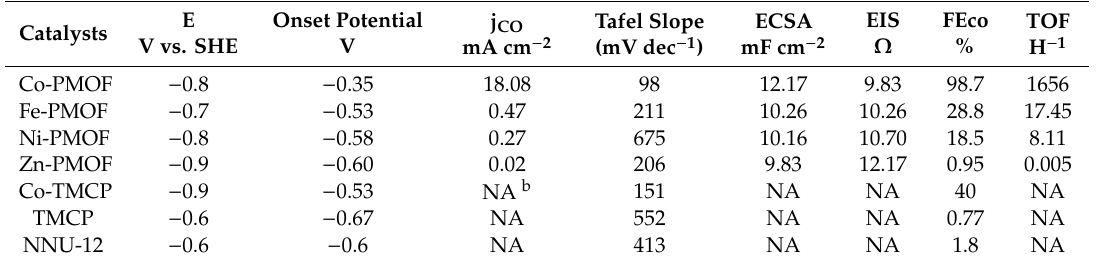
Table 6. CO 2 electroreduction performances